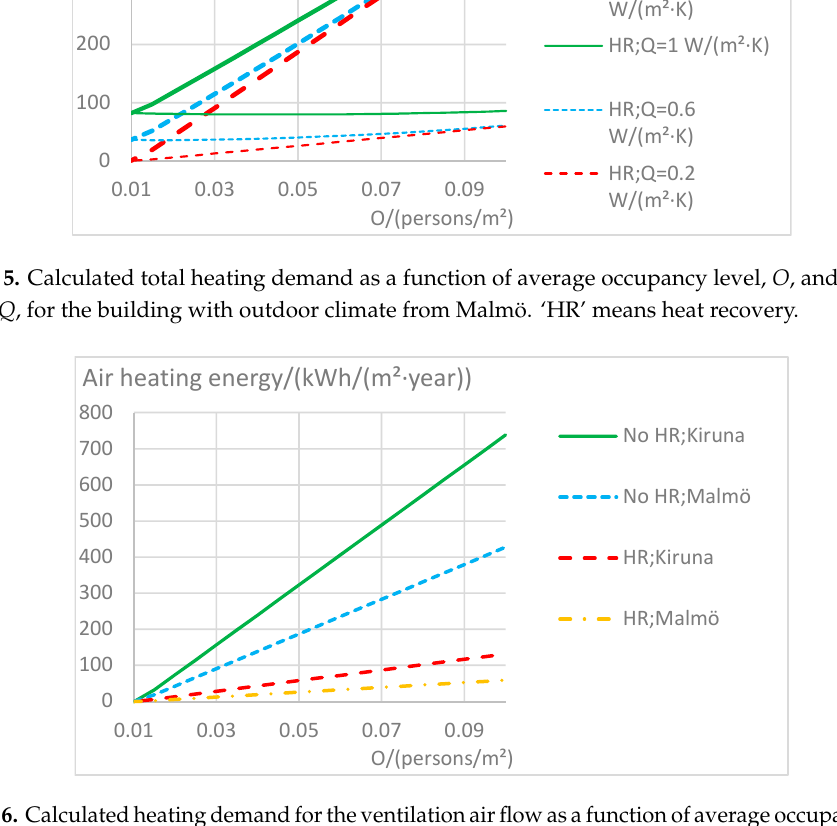
Figure 6. Calculated heating demand for the ventilation air flow as a function of average occupancy level, O , with outdoor climate from Kiruna and Malmö with and without heat recovery (HR). The heat-loss factor is 0.1 W/(m 2 ·K).